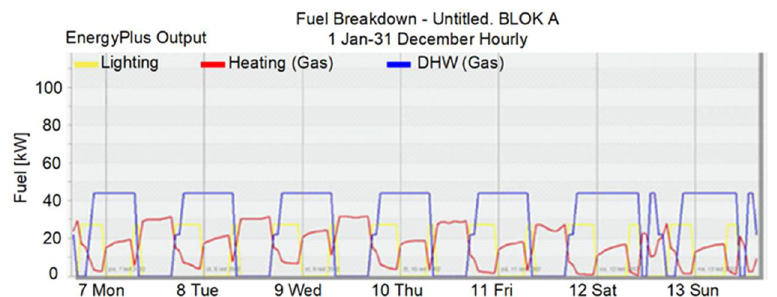
Figure 17. Energy consumption after the reconstruction of Block A in winter (weekly part). Table 10. Power consumption before the reconstruction.